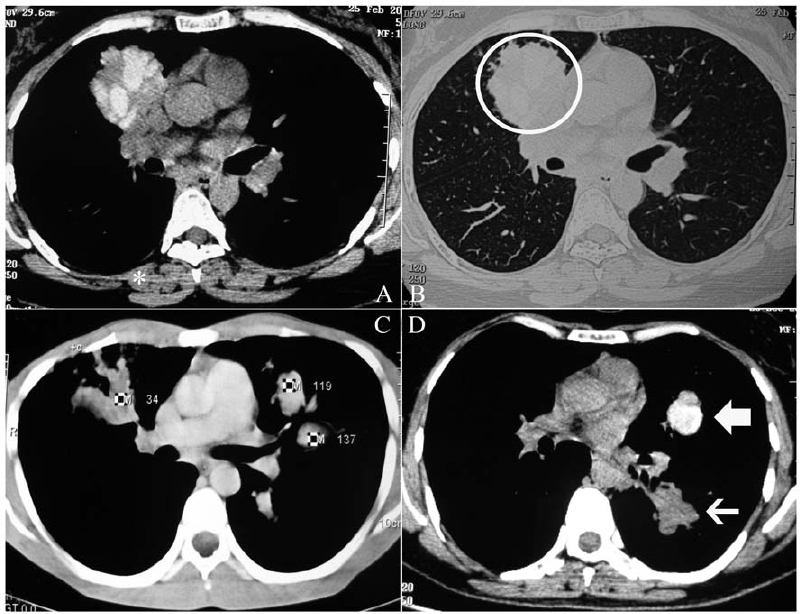
Figure 2. High-resolution computed tomographic images of patients with allergic bronchopulmonary aspergillosis demonstrating the presence of high-attenuation mucus. (A) Mediastinal window showing the presence of hyperattenuated mucus within dilated bronchi. The mucus is denser than the paraspinal skeletal muscle (asterisk) (B) Lung window shows that hyperdense mucus can occasionally be appreciated even with the parenchymal sections (circle); (C) CT Hounsfield values of mucus in dilated bronchi: mucus in the left lung is hyperdense with higher CT attenuation values compared to mucoid impaction in the right lung; (d) Hyperattenuated (bold arrow) and normal attenuation mucus (thin arrow) in the same mediastinal